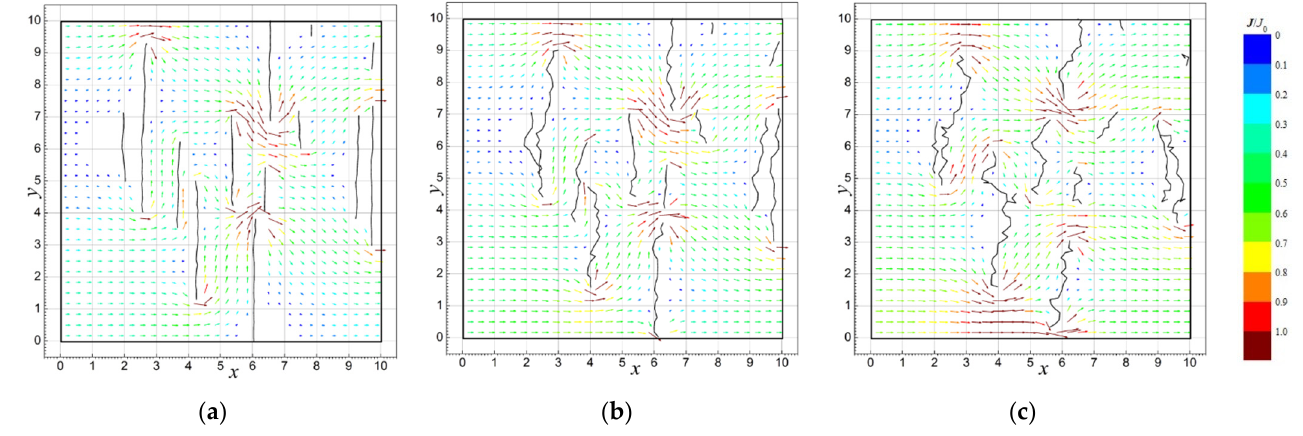
Figure 5. The results of simulation the relative current flow field J / J 0 in the analyzed model of the conductive layer with line defects for different values of the parameter σ α : ( a ) 5°, ( b ) 25°, and ( c ) 45°; N = 13 (units of x , y are conventional) .